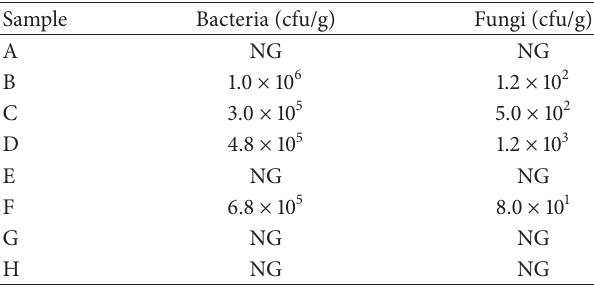
Table 2: Microbial counts in freshly baked bread.